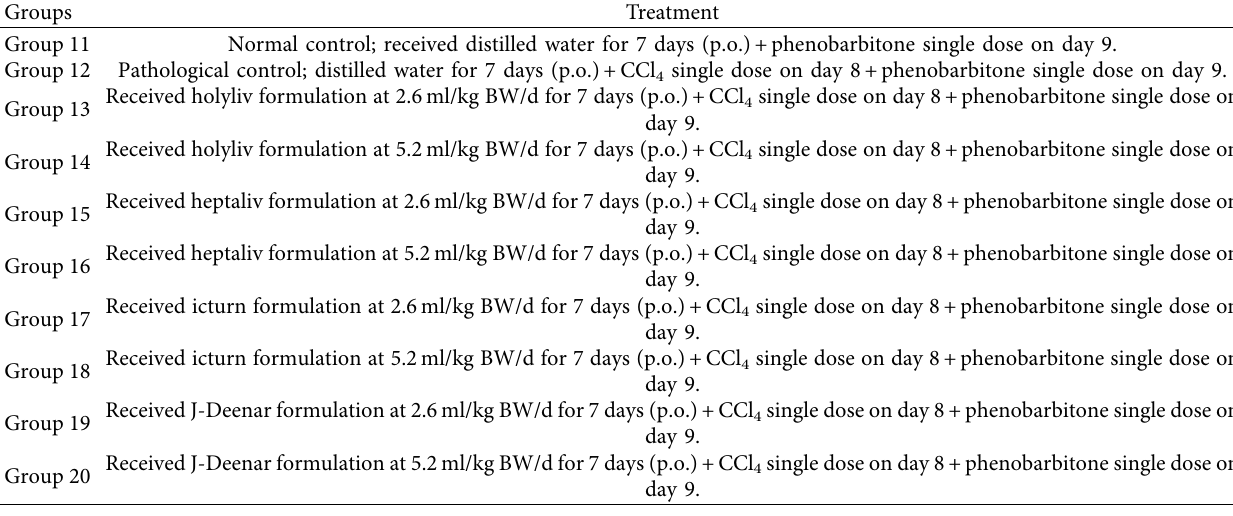
Table 3: Dosage of orally administered drug in various groups in phenobarbitone-induced sleeping time. Groups Treatment Group 11 Group